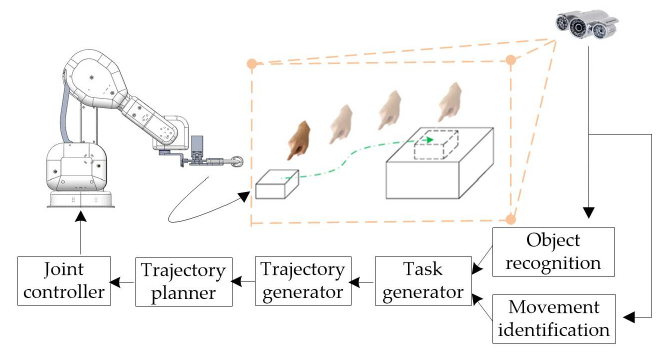
Figure 1. Route chart of teaching a manipulator by vision guiding, without programming the device.